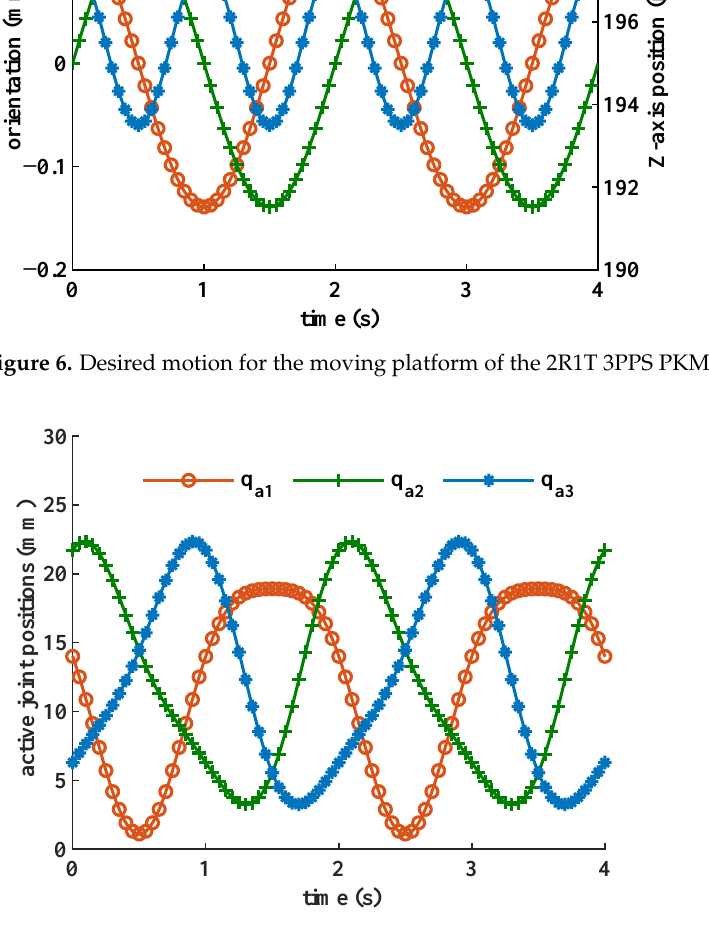
Figure 7. Desired motion for the active joints of the 2R1T 3PPS PKM.